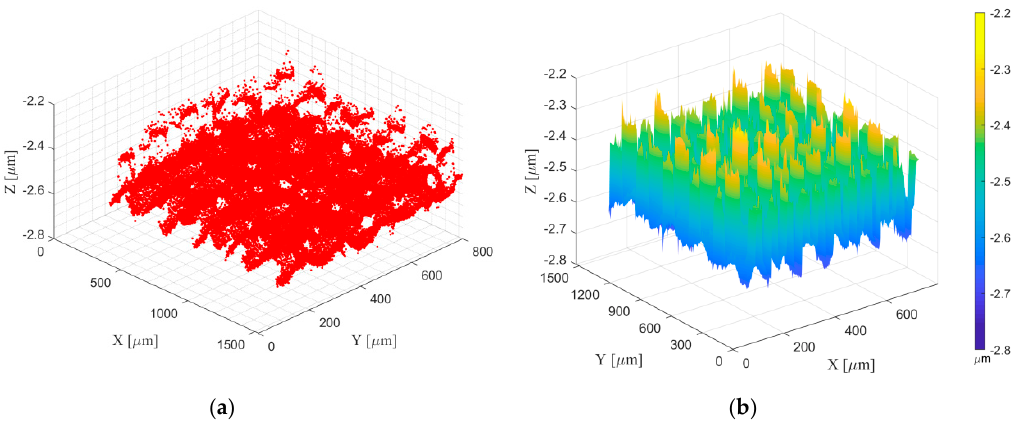
Figure 5. Reconstruction of the rotated surface: ( a ) point plot; ( b ) surfplot using Z for the color data.